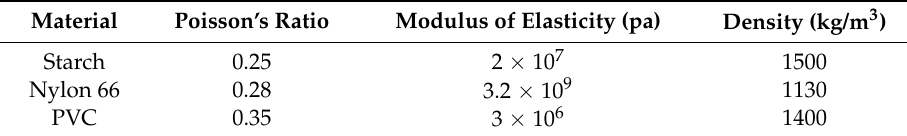
Table 1. Material properties.